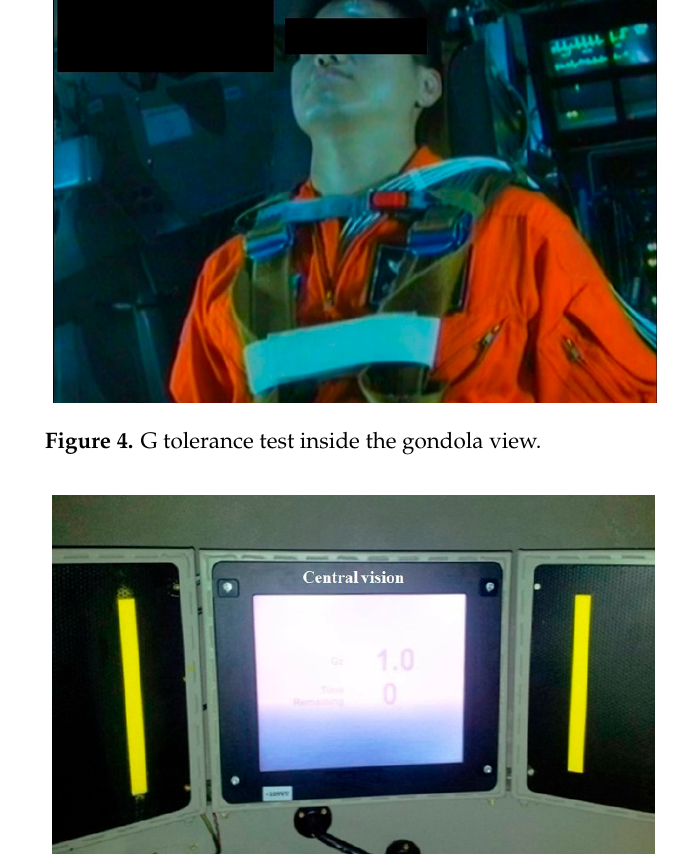
Figure 4. G tolerance test inside the gondola view.